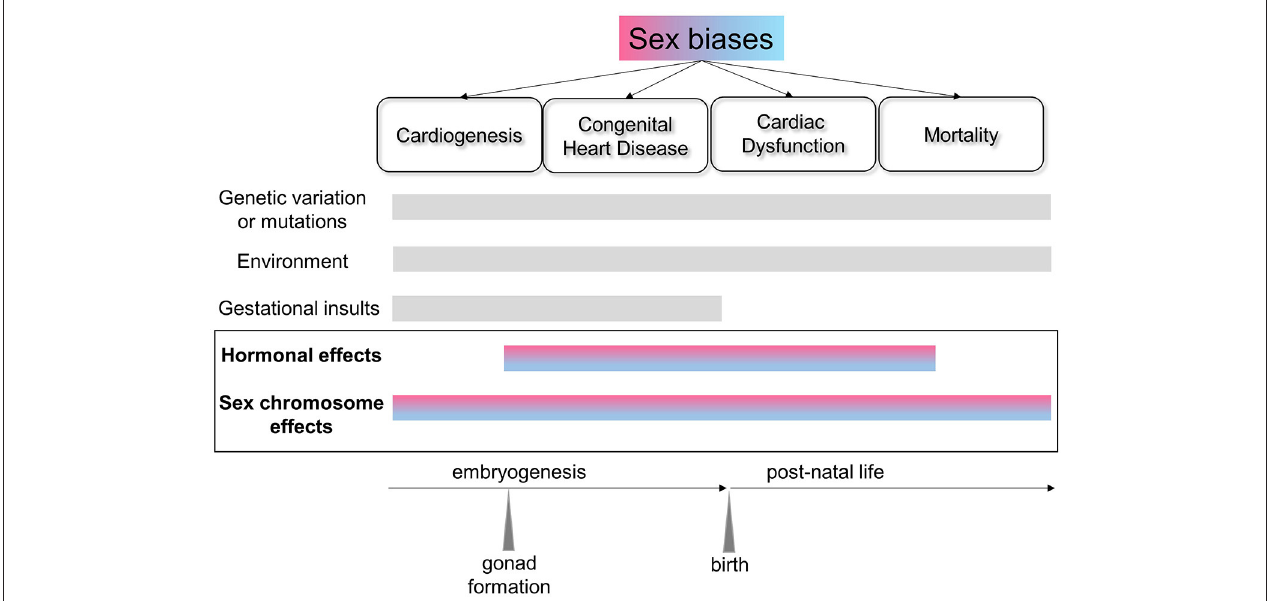
FIGURE 1 | Schematic of the factors affecting sex biases in the heart across the lifespan. Sexual dimorphism exists at the molecular level from early cardiac development and across the lifespan, and is reflected in the sex biases evident in congenital heart disorders and cardiovascular health and disease. In addition to genetic, environmental and gestational factors, sex chromosome-linked genes and their interactions with hormonal effects are critical in establishing sex differences in the